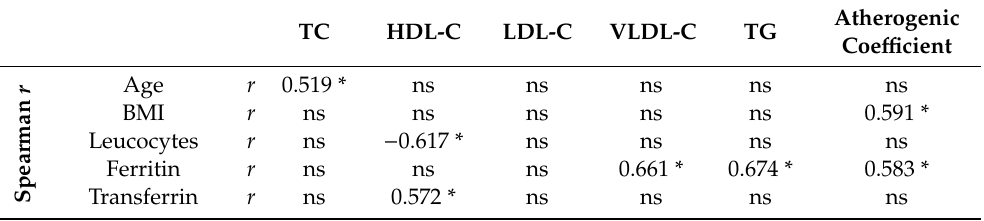
Table 8. Correlations between lipid profile, inflammatory markers and parameters of iron metabolism in healthy